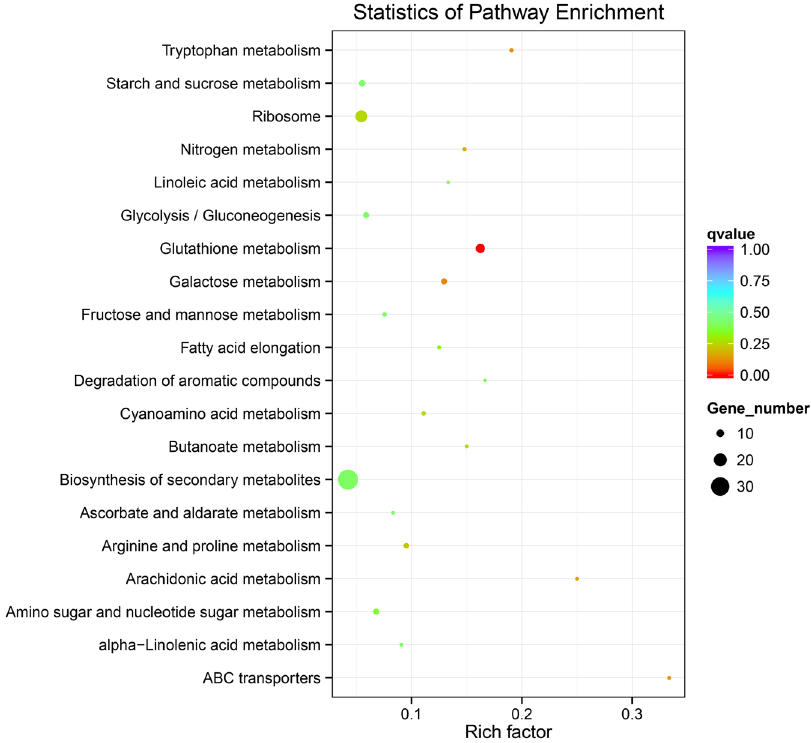
Figure 5. Significantly enriched Kyoto Encyclopedia of Genes and Genomes (KEGG) pathways (p < 0.05) in B8 VS A8. A8: N0 seeds at 8 HAI. B8: N240 seeds at 8 HAI.